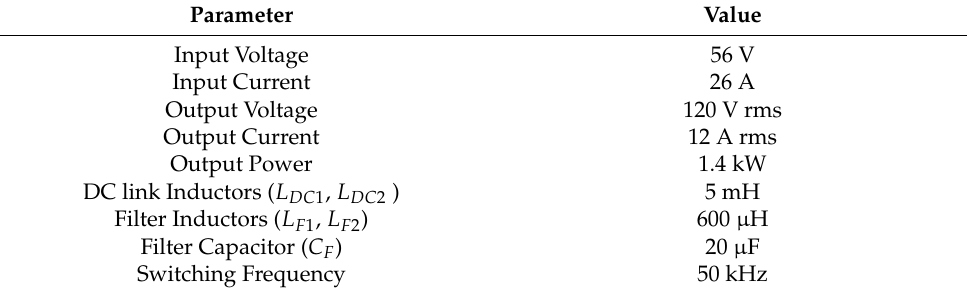
Table 3. Simulation parameters of the proposed half-bridge CSI Table II. Ziegler–Nichols control parameters for P and I gains.